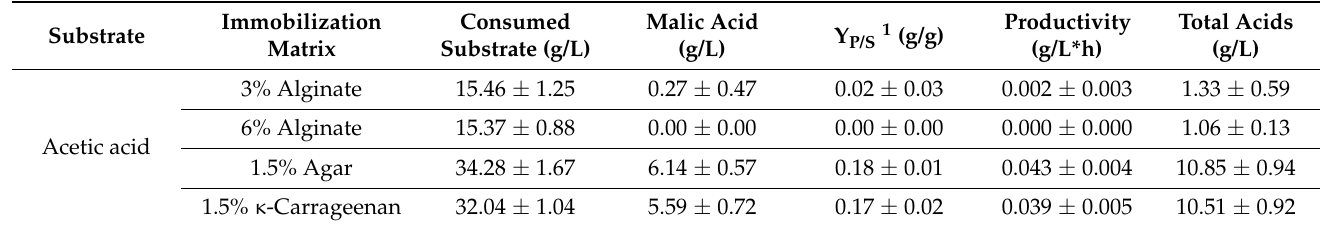
Figure 7. Malic acid production with immobilized A. oryzae grown in a preculture medium without carbon source. Acetate was used as carbon source for acid production in the main culture. Values are means of triplicates with standard deviation. Table 3. Fermentation results for shake flask cultivations of A. oryzae after 144 h using acetate as carbon source in the main culture, while preculture was grown without carbon source in medium. Values are means of triplicates with standard deviation.